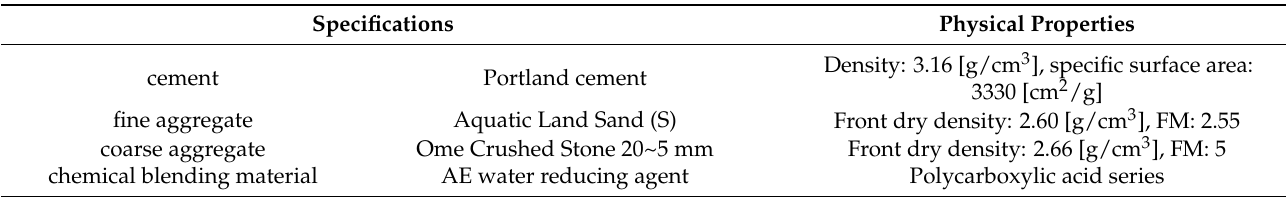
Table 2. Materials used.